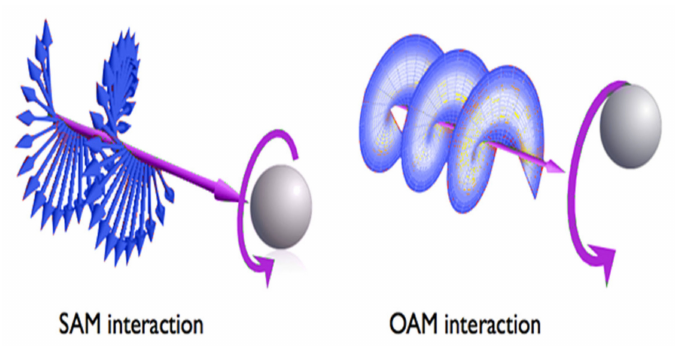
Figure 1. Waveforms of OAM and